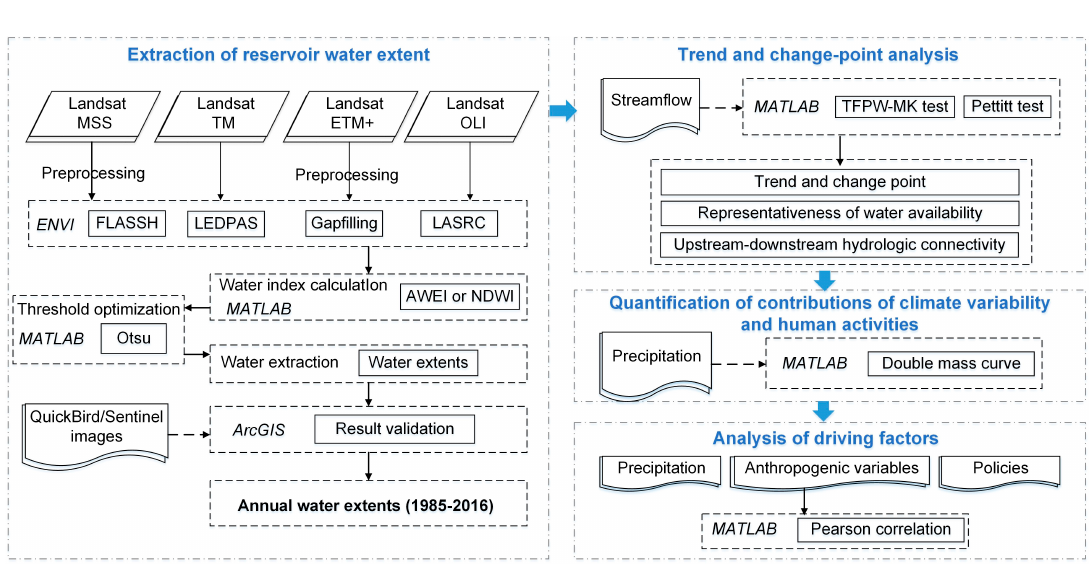
Table 1. Anthropogenic variables used in this study.